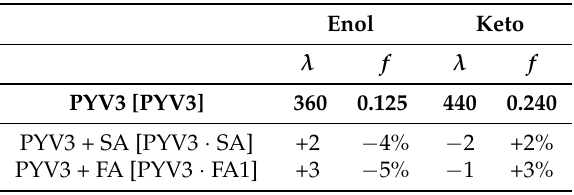
Table 2. RI-CC2/def2-TZVPD first excitation energy ( λ , in nm) and oscillator strength ( f ) for